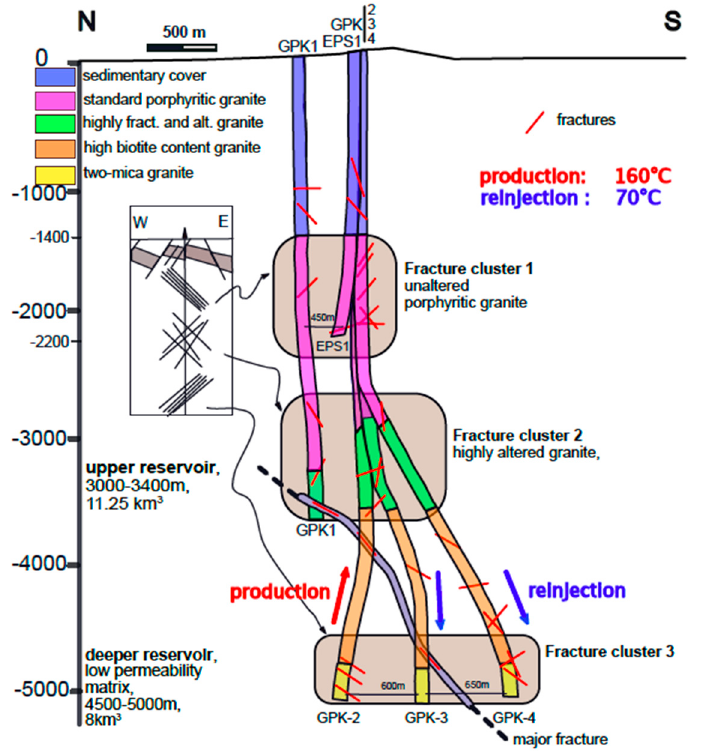
Figure 4. The Soultz EGS with the pilot plant composed of GPK ‐ 2, GPK ‐ 3 and GPK ‐ 4 (modified after [39]). − 1400 m: depth of the basement roof; − 2200 m: bottom of EPS ‐ 1 borehole. Standard porphyritic granite represents the fresh facies while highly fract. and alt. granite (highly fractured and altered granite) are the hydrothermally altered facies. Fracture clusters are described in [38,39].